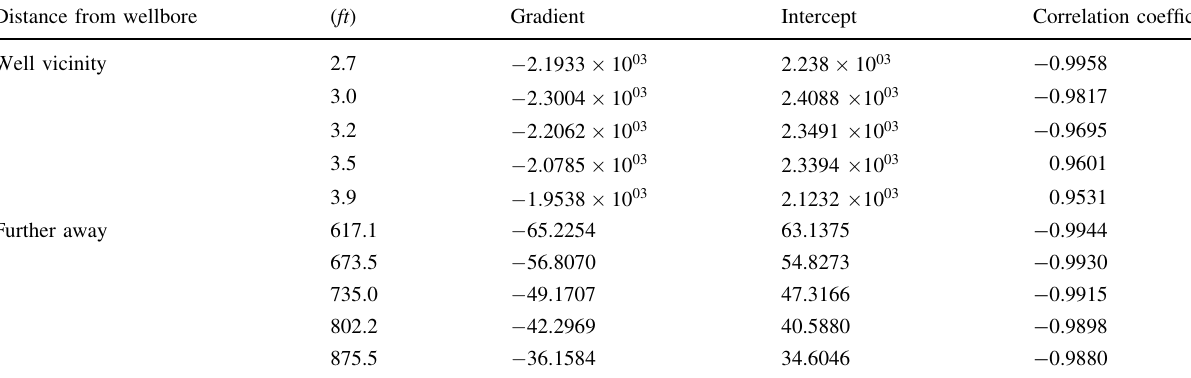
Table 2 Dependence of the level of heterogeneity, a and pressure drop Distance from wellbore